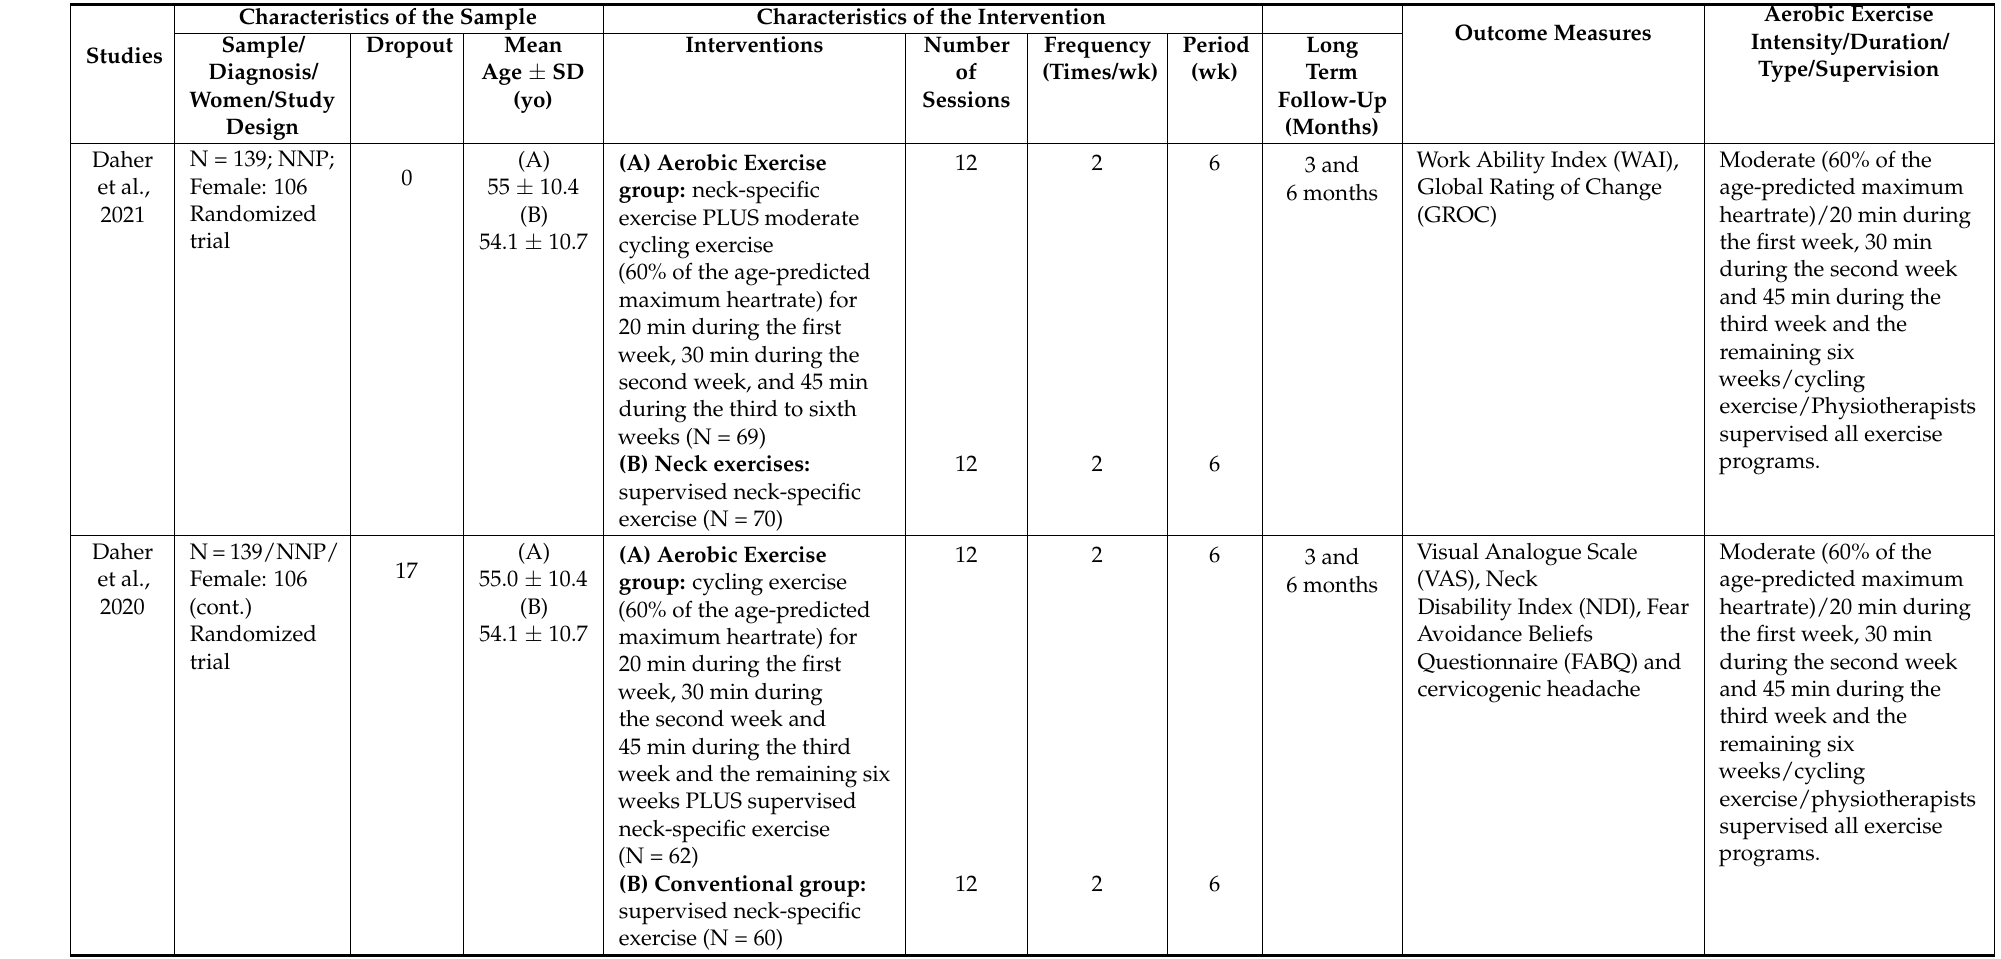
Table 1. Characteristics of the included studies